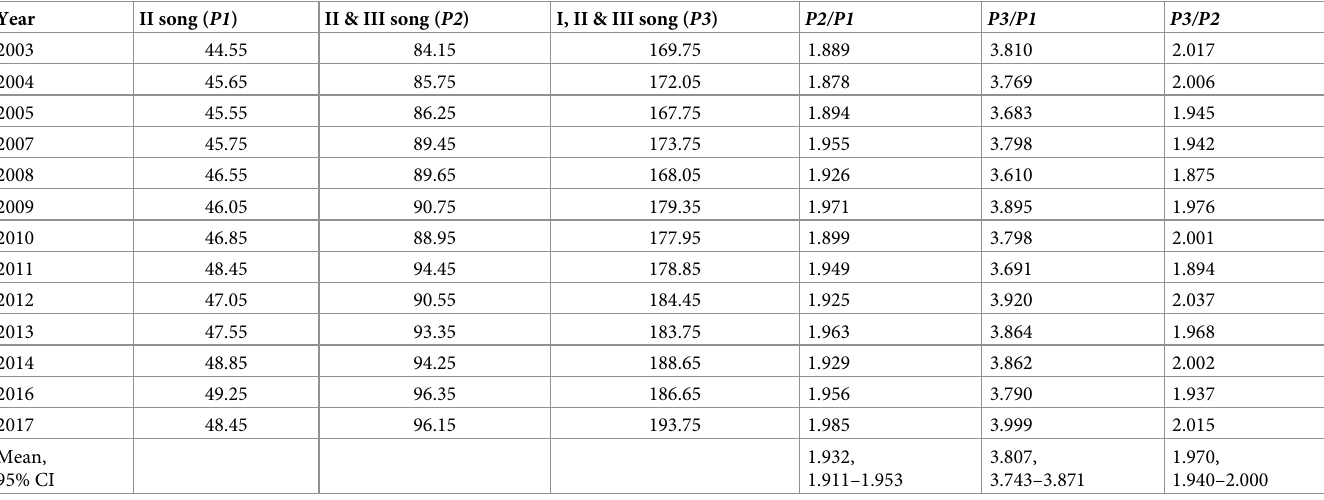
Song to song repeat interval (s) given by feature space analysis and ratios of these for each year, with: year; ( P1 ) time between consecutive type II only songs (s); ( P2 ) time between consecutive type II & III only songs (s); ( P3 ) time between consecutive type I, II &III songs (s); ratio P2/P1 ; ratio P3/P1 ; ratio P3/P2 .